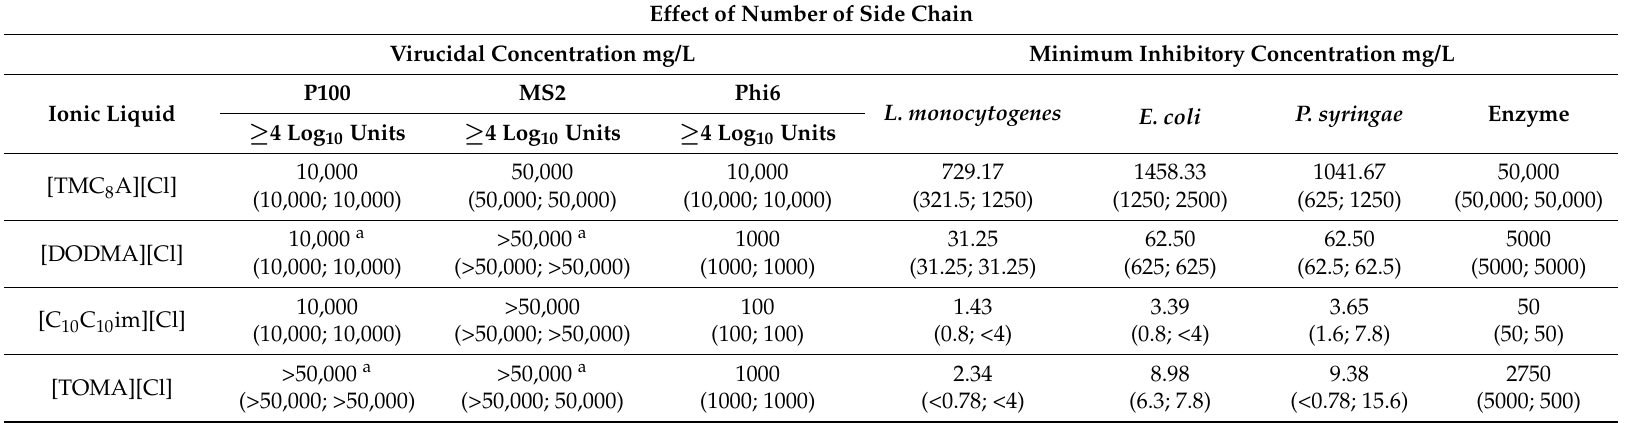
Table 1. Effect of the number of side chains investigated on three bacteriophages, related bacterial host strains and enzyme